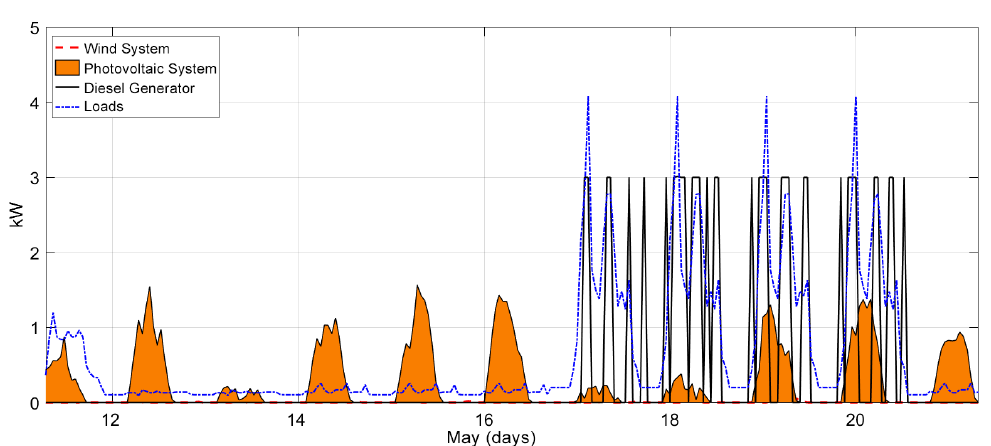
Figure 5. Output power from power sources and system loads between 12 to 20 May.